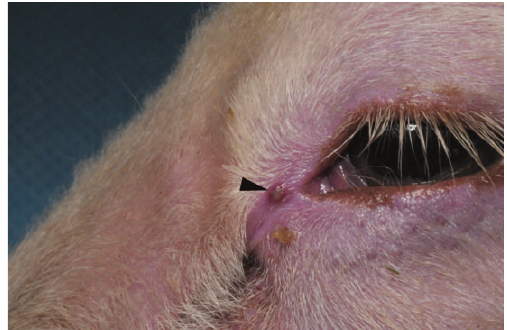
Figure 2: Left palpebrae, medial canthus. Focal hemorrhagic pus- tule (arrowhead).